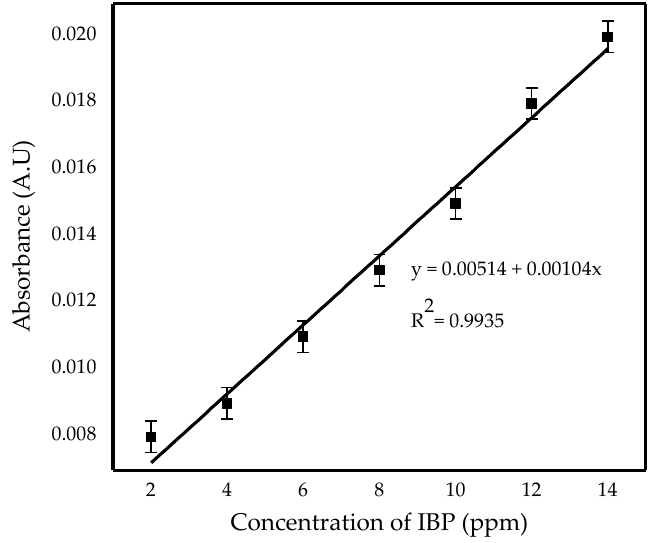
Figure 3. Calibration curve UV-Vis absorbance against concentration of IBP (ppm) .